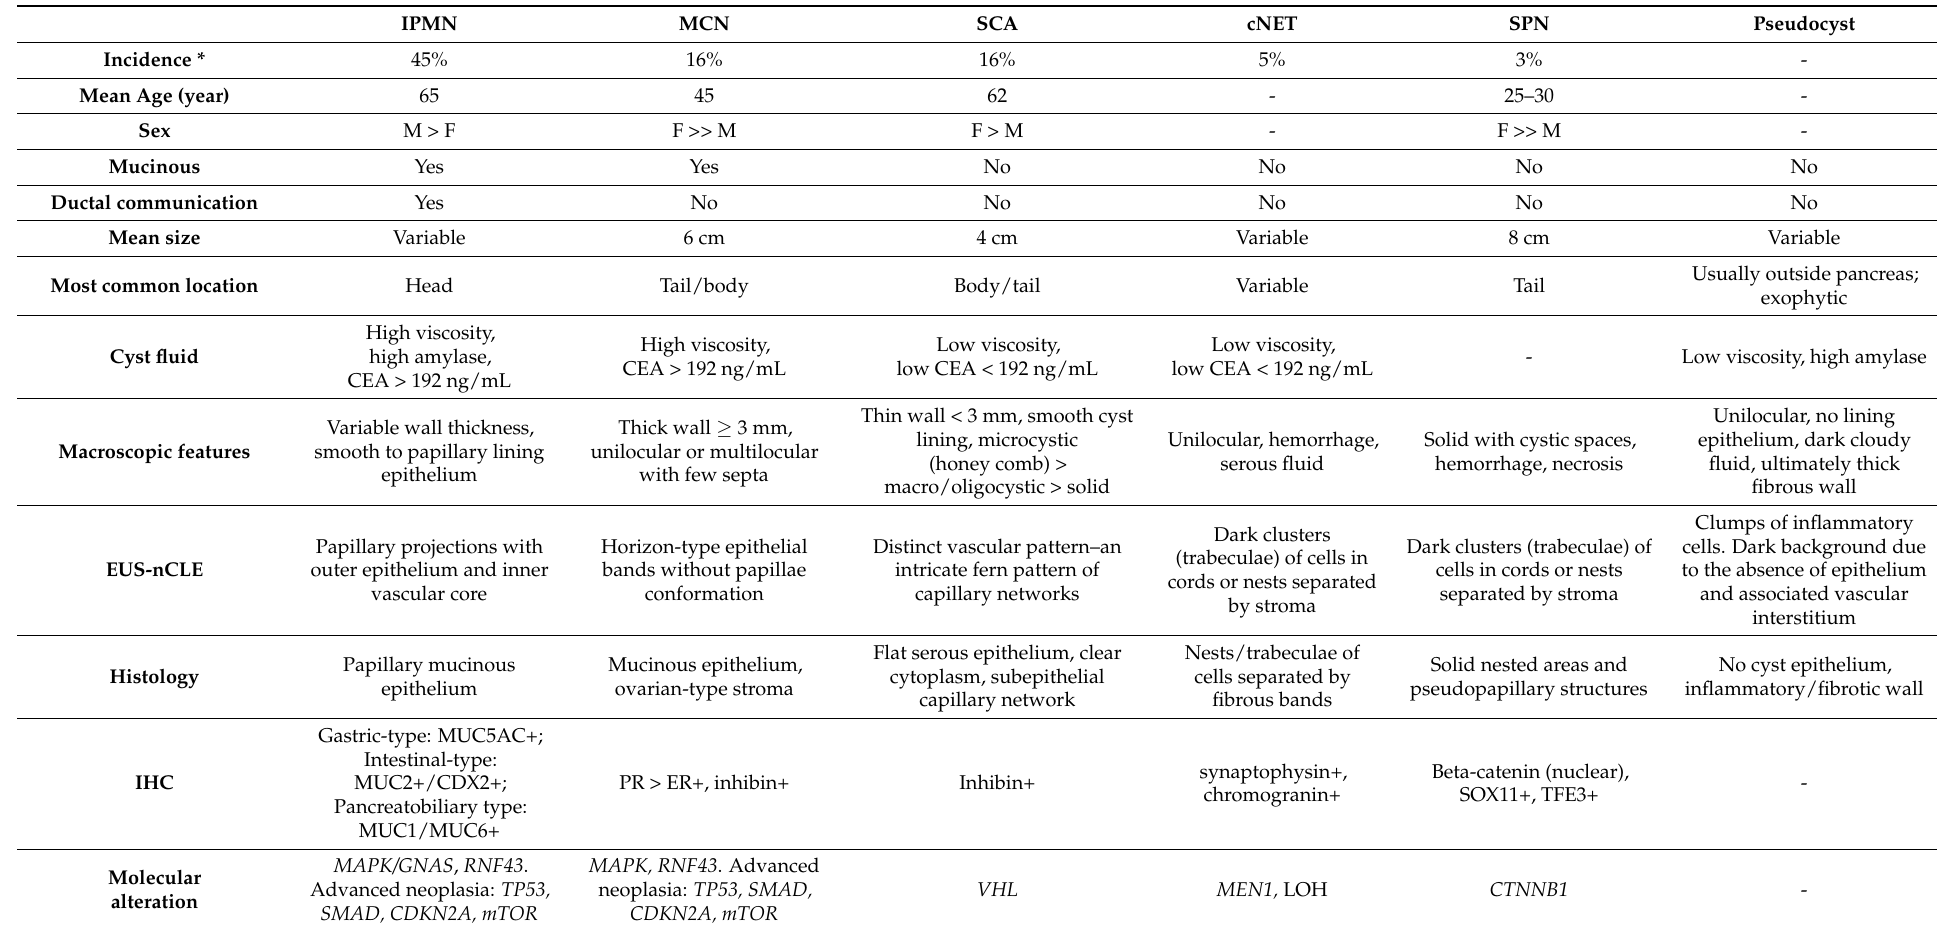
Table 1. Comparison of clinicopathological features of pancreatic cystic